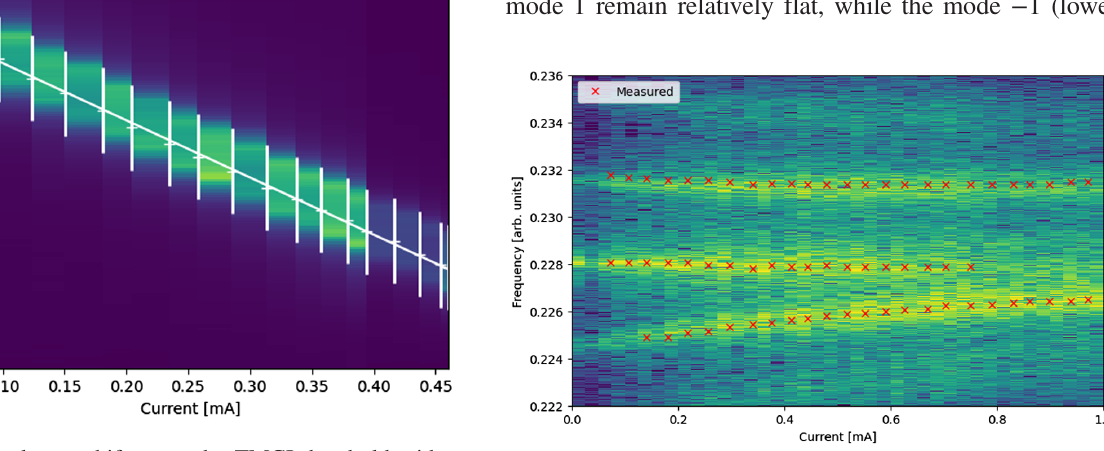
FIG. 11. Horizontal mode shift at Q 0 ¼ 1 . 5 . The red crosses are peaks coming from the measured spectrum, whereas the colored background is the simulated